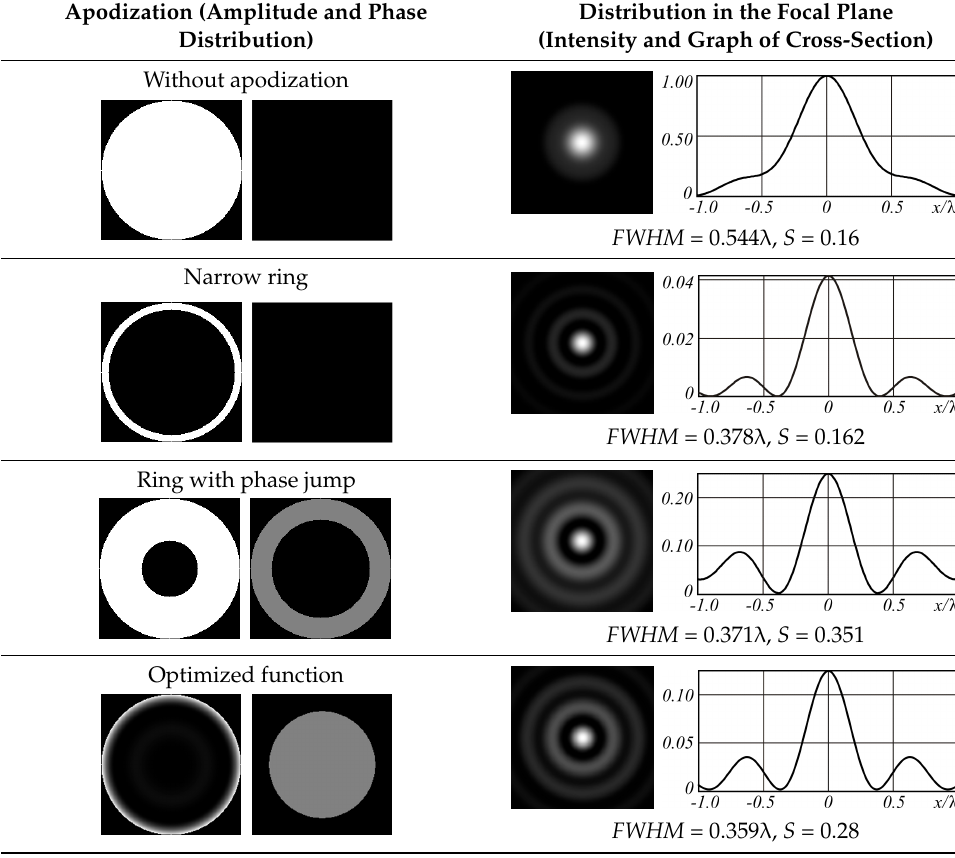
Table 1. Comparing results for a tightly focused radially polarized beam with different types of pupil function apodization ( S is the sidelobe level).